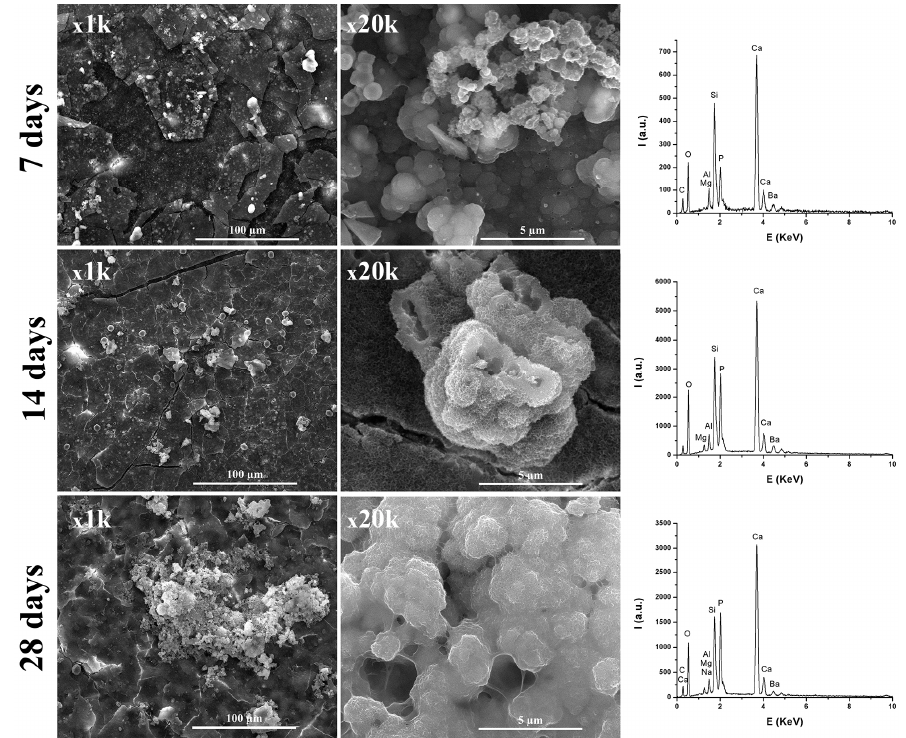
Figure 8 . Scanning electron micrographs at different magnifications and elemental analysis of the Figure 8. Scanning electron micrographs at di ff erent magnifications and elemental analysis of the TheraCal surface at 7, 14, and 28 days, which show mineralization. TheraCal surface at 7, 14, and 28 days, which show mineralization. Materials 2019 , 12 , x FOR PEER REVIEW